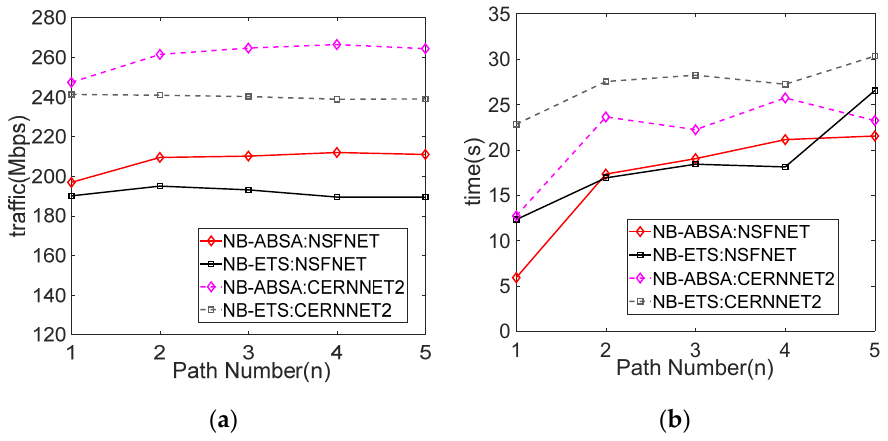
Figure 7. The total network service traffic and algorithm convergence time vary with the number of routing paths: ( a ) traffic; ( b ) time.